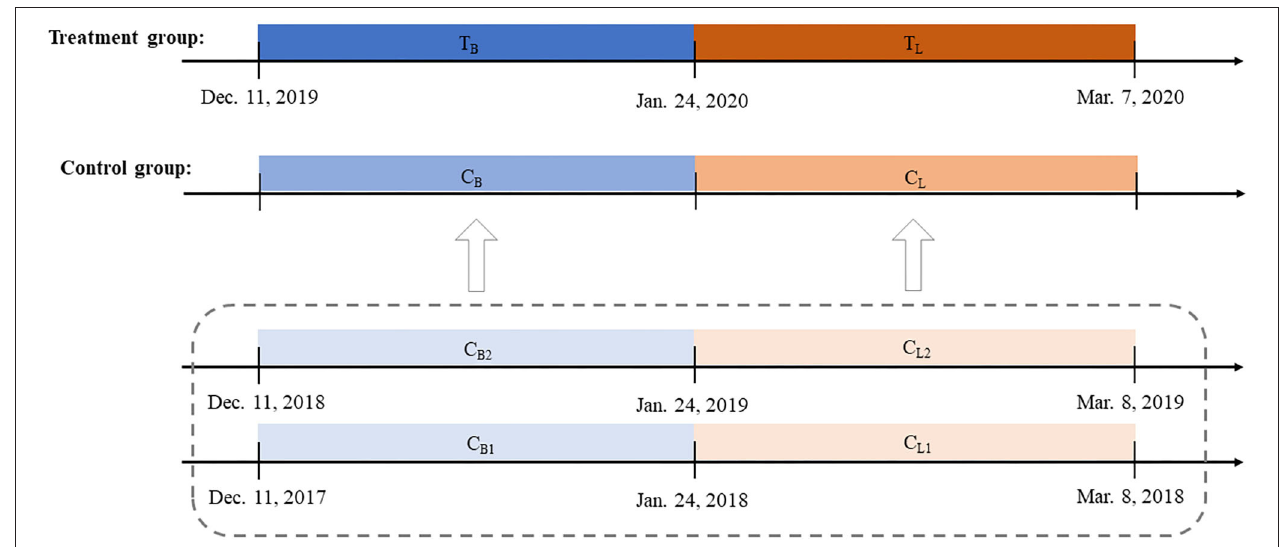
FIGURE 1 | Settings of the difference-in-difference (DID)